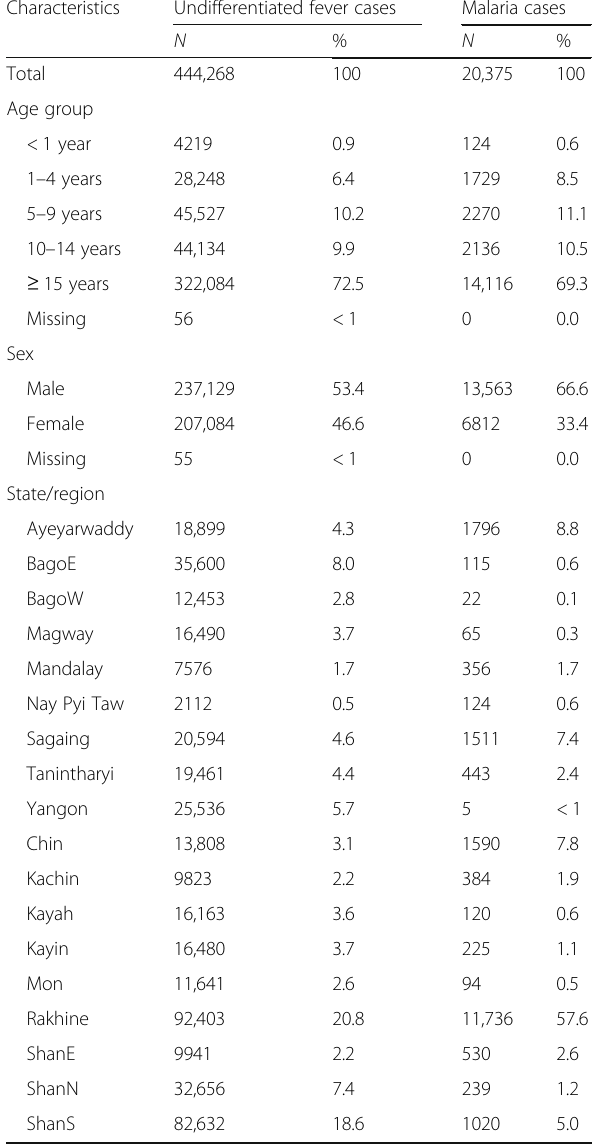
Table 2 Demographic characteristics of undifferentiated fever and malaria cases identified by village health volunteers in Myanmar, 2016